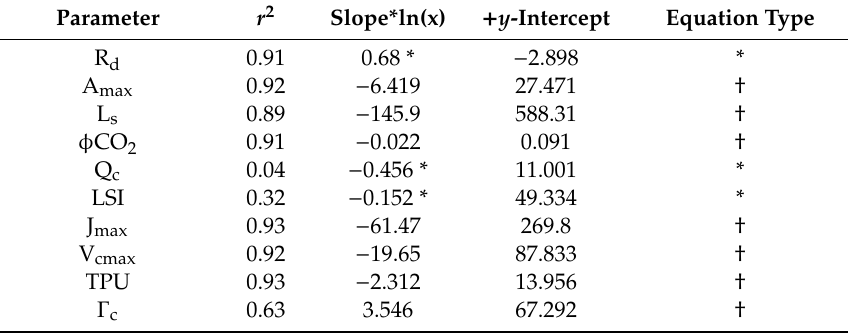
Table 3. Rate of change over time logarithmic and / or linear regression equations between leaf age and physiological parameters. Samples were pooled for treatments and crown position and fitted with either a linear (*) or logarithmic ( † ) equation. Leaf respiration rate (R d ), quantum yield ( φ CO 2 ), maximum photosynthesis (A max ), leaf light saturation (L s ), light compensation point (Q c ), maximum electron transport rate (J max ), maximum Rubisco carboxylation rate (V cmax ), triose phosphate utilization (TPU), CO 2 compensation point ( Γ c ), and leaf spectral index (LSI, a proxy for leaf nitrogen content, chlorophyll a + b concentration, and greenness characteristics) versus leaf age. Total number of leaves = 27. Parameter r 2 Slope*ln(x) + y